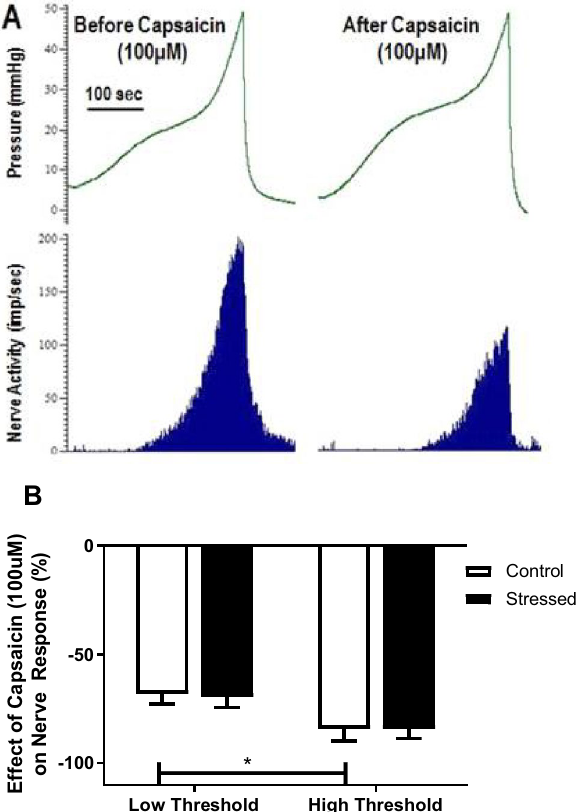
Figure 5. Example pressure (mmHg) and nerve activity (imp/s) traces ( A ) during bladder distension before and after capsaicin (100 μM) in a control bladder. Effect of capsaicin (100 µM) on low and high threshold fibre responses at maximum bladder distension in control and stressed bladders ( B ), data represented as a percentage of the maximum nerve response to distension before capsaicin administration (mean ± SEM, n ≥ 17). Data analysed by Students t test (*p < 0.05 low vs high threshold nerves).